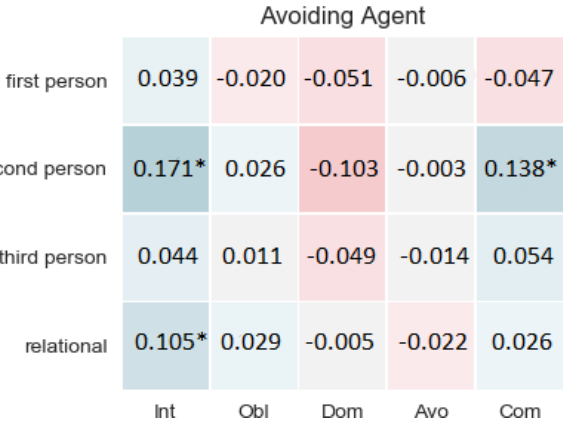
Figure 5. Correlation coefficients between first person, third person and relational pronouns used during the interaction with the Avoiding virtual agent and the ROCI-II scores. (*) Significant values ( p < 0.05) are marked with